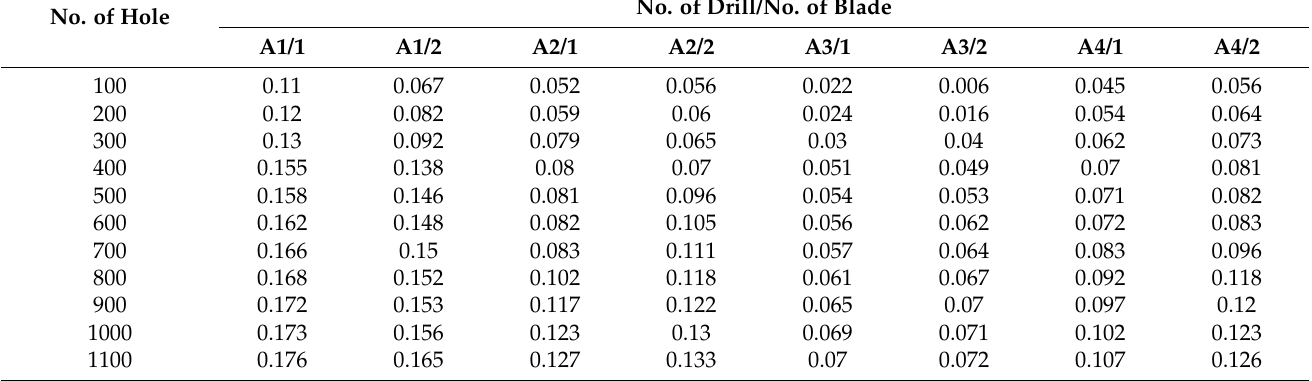
Table 2. The values of outer corner wear (W) measured while monitoring the condition of drill bits from Group A (control group containing four two-blade tools that were unmodified). The table contains the data shown in Figure